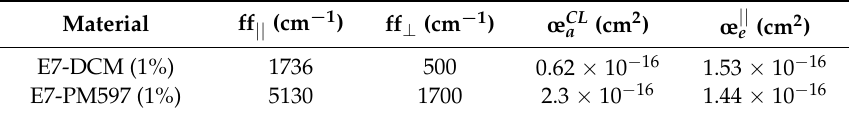
Table A1. Absorption parameters at λ = 532 nm and emission cross-sections at the corresponding lasing wavelengths (605 nm for DCM and 590 nm for PM compounds).